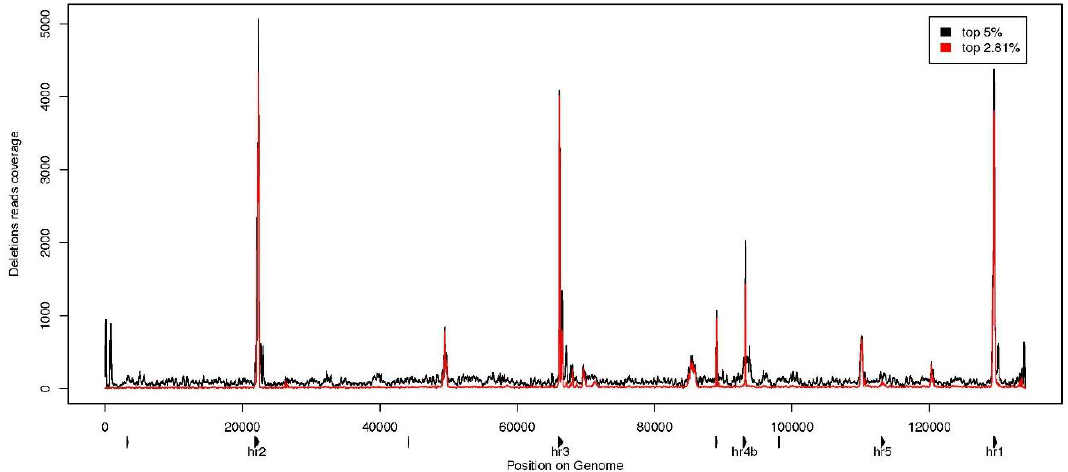
Figure 5. Deletion reads coverage along the AcMNPV-WP10 genome. The 5% (in black) and 2.81% (in red) reads presenting the highest pair distance were mapped on the genome. The coverage by these reads is shown all along the WP10 consensus genome, revealing deletion hotspots. The triangles represent the positions of the hrs on the genome. Hrs with their name under the triangle have been studied in more depth. The 2.81% reads are more distant than 669 nt that is the length of hr2 , the largest hr . By comparing these two sets, we show that not only deletions of palindrome repeats in the hrs are present in the population, but also larger deletions, possibly occurring between two hrs .